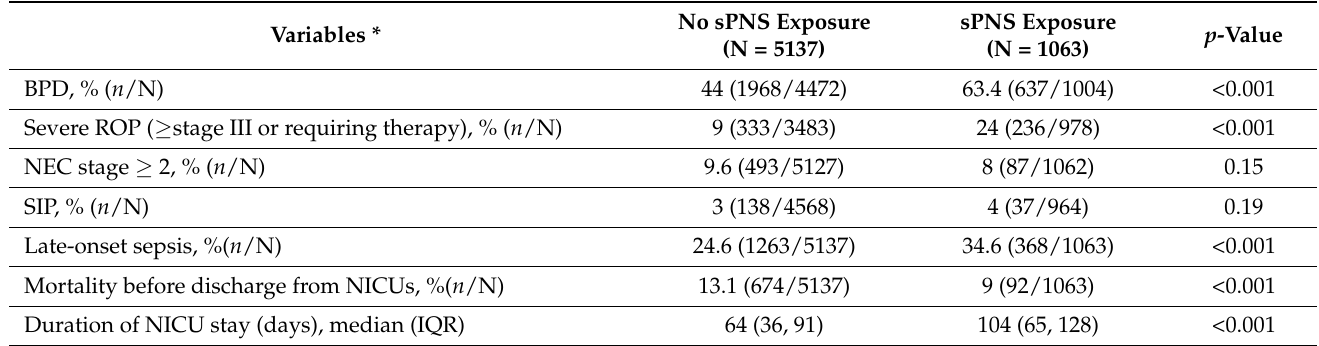
Table 2. Short-term outcomes of infants based on exposure to systemic postnatal steroids.